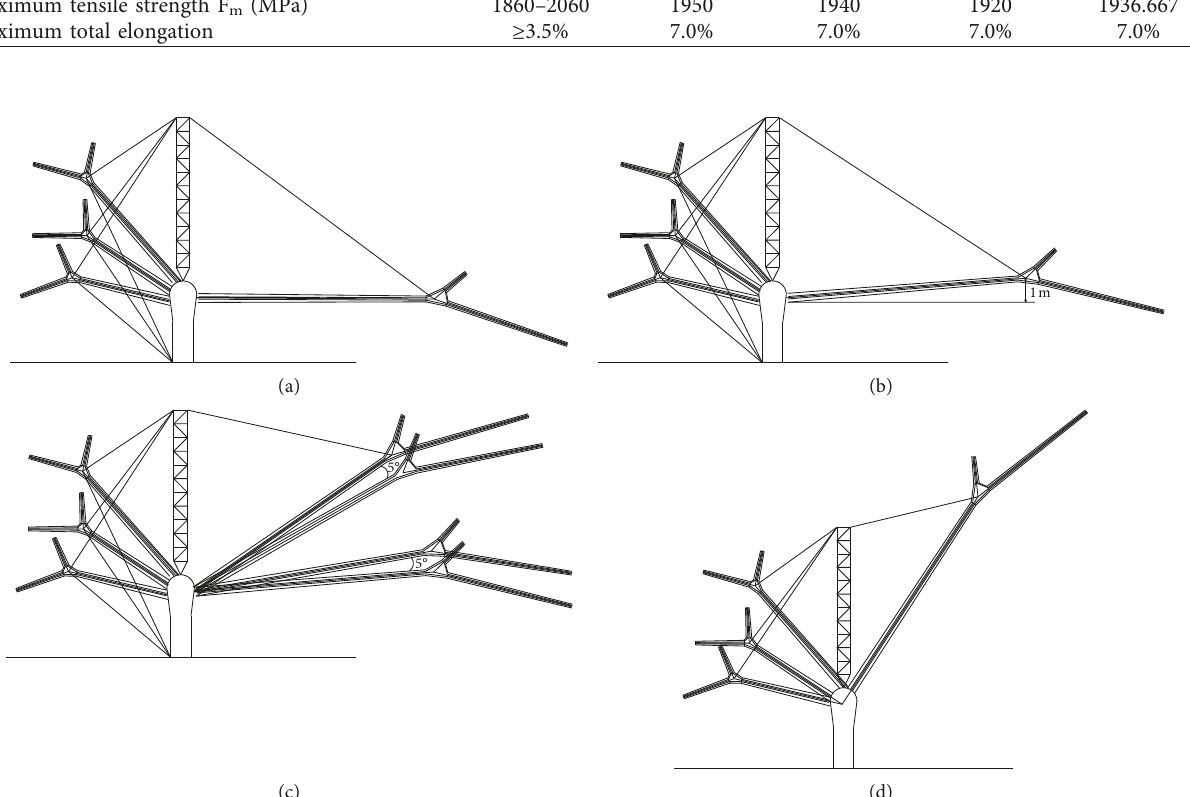
Figure 13: Construction process simulation. (a) Step 1. (b) Step 2. (c) Steps 3–12. (d) Step 13.